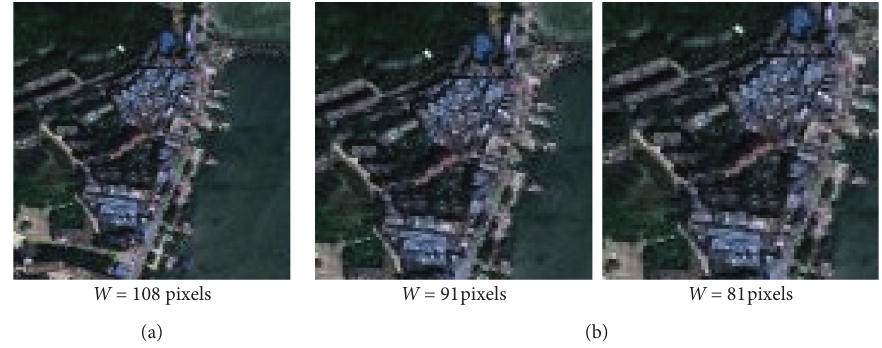
Figure 6: An example of multiscale random sampling. (a) Original image, (b) Multiple random samples.